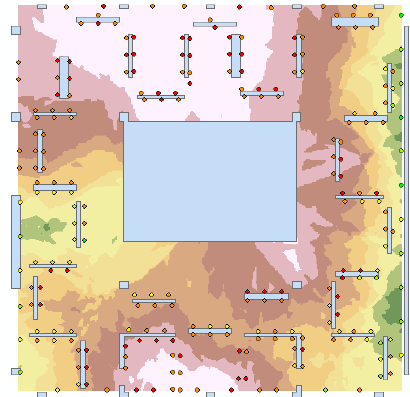
Figure 14. Heatmap of viewing patterns after three hours Observing the three heat maps generated from the 10% chance models, it is spotted that after three hours, artworks from the eastern and western part of the exhibit area are viewed at least once. Areas such as the upper part of the exhibit shows the least number of visitors. This may be attributed to the fact that this part is the farthest from the entrance of the main